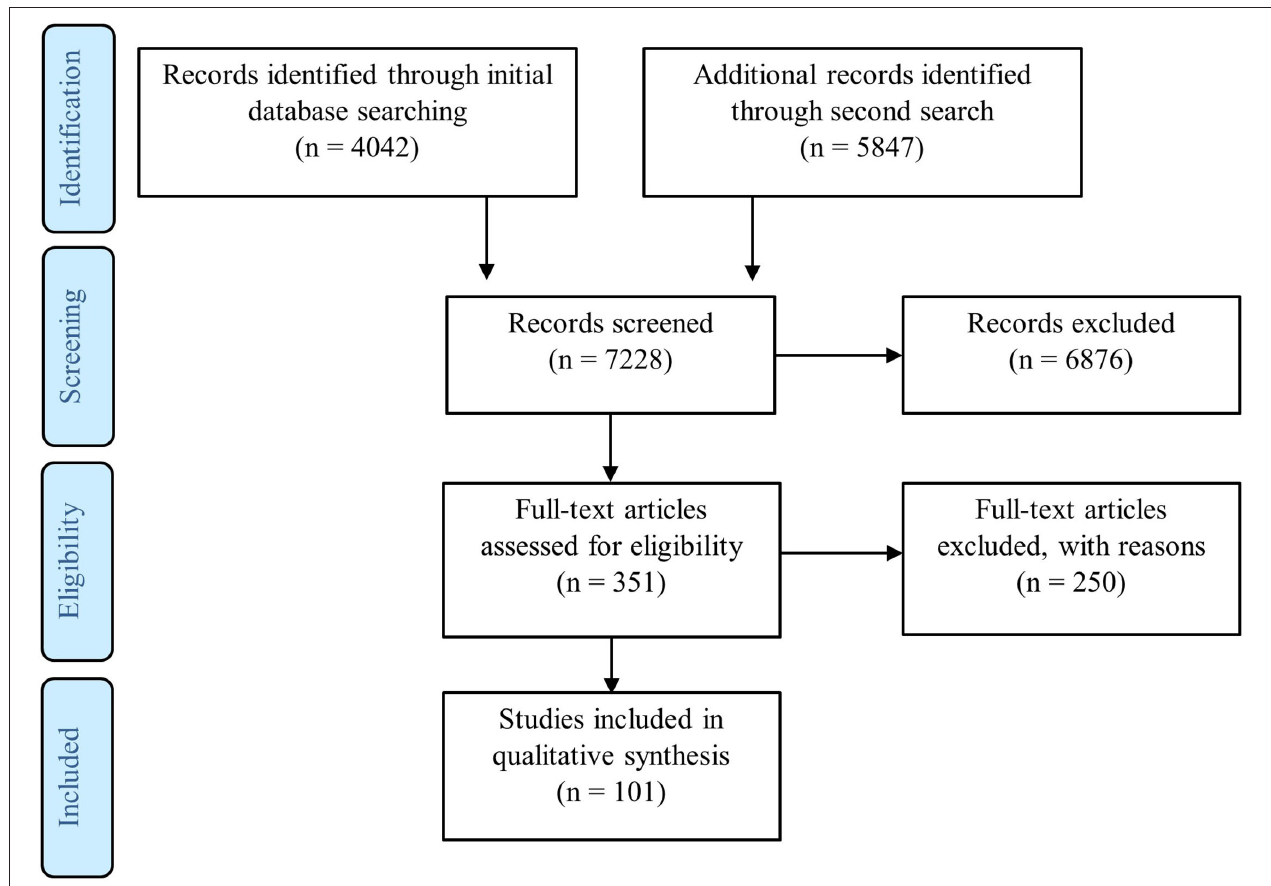
FIGURE 1 | PRISMA statement showing flow of information through the different phases of a systematic review (Moher et al., 2009). This PRISMA diagram contains public sector information licensed under the Open Government Licence v3.0. Adapted from Moher et al.